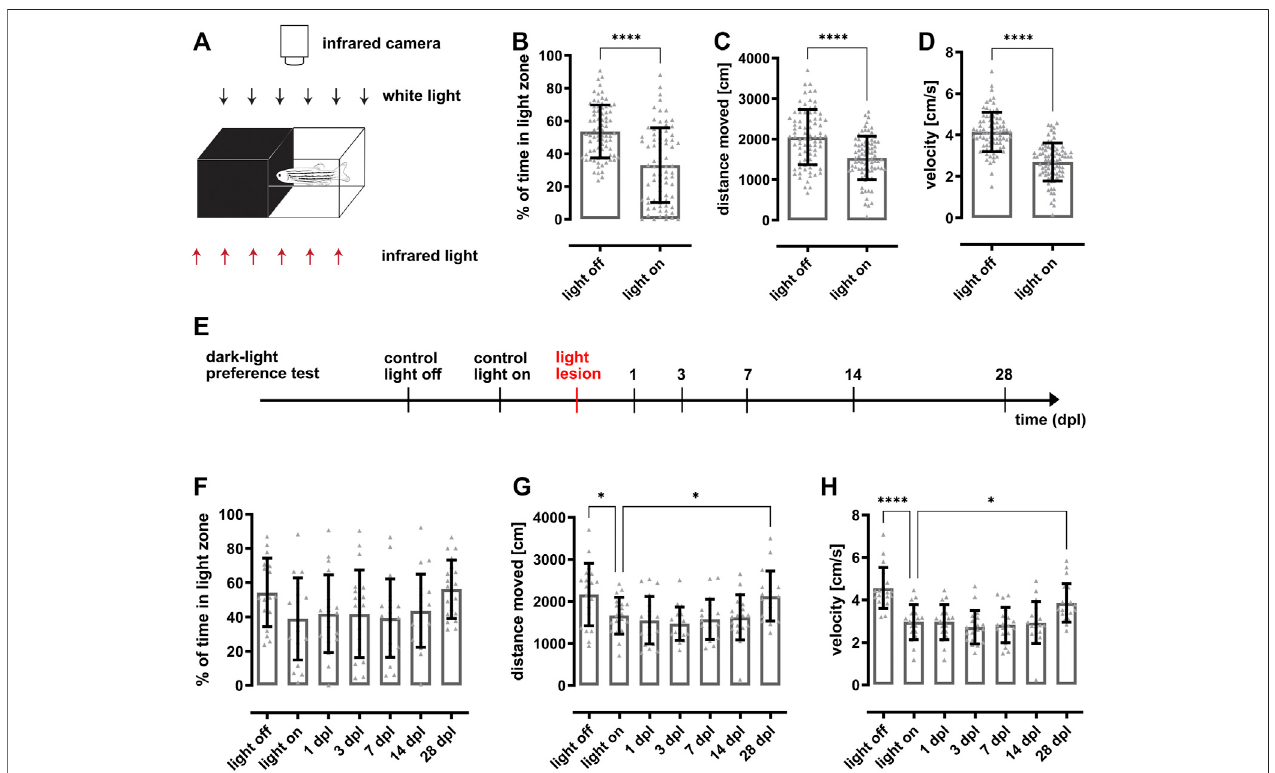
FIGURE 1 | Dark-light preference behavior is statistically signi fi cant but highly variable impeding assessment of vision loss and recovery after light lesion. (A) Schemeofthedark-lightpreferencesetup.Theindividualcompartmentsofthecustom-madearenaconsistofinfrared-transparentmaterial.Onehalfismadefromclear, the other half made from black plastic establishing a light and dark zone, respectively. The test fi sh can freely swim within the whole compartment, which can be illuminated with white light from the top (85 lux). In addition, the arena is illuminated from an infrared light source located beneath the arena and recorded from the top using an infrared-sensitive camera. (B) Quanti fi cation reveals that the time fi sh spent in the light zone is signi fi cantly higher in the light off condition (53.6 ± 16.1%) comparedtothelightoncondition(32.9 ± 22.7%).Quanti fi cationsofthedistancemoved (C) andthecorrespondingvelocity (D) showthatthe fi shswamsigni fi cantlyless (lightoff: 2060 ± 683 cm; light on: 1537 ± 543 cm) and slower (lightoff: 4.2 ± 0.9 cm/s; lighton: 2.7 ± 0.9 cm/s) inilluminatedcondition. (E) Experimental timeline. Dark- light preference recordings were performed in light on and light off conditions prior to light lesion as well as in light on conditions at 1, 3, 7, 14, and 28 days post lesion (dpl). (F) Quanti fi cationofthetimespentinthelightzonerevealsthat fi shdonotchangetheirpreferenceforthedarkorlightzoneafterlightlesion (lightoff:54.3 ± 19.5%, light on: 38.9 ± 23.4%, 1 dpl: 41.9 ± 22.1%, 3 dpl: 41.8 ± 24.9%, 7 dpl: 39.3 ± 22.2%, 14 dpl: 43.6 ± 20.9%, 28 dpl: 56.3 ± 16.6%). Similarly, quanti fi cations of the distance moved (G) and velocity (H) show no lesion-dependent alterations. Statistics: all data are represented as mean ± SD, unpaired t-test (B – D) , one-way ANOVA with Dunnett ’ s multiple comparison test against control (F – H) , p < 0.05 (*); 0.01 (**); 0.001 (***) or 0.0001 (****).